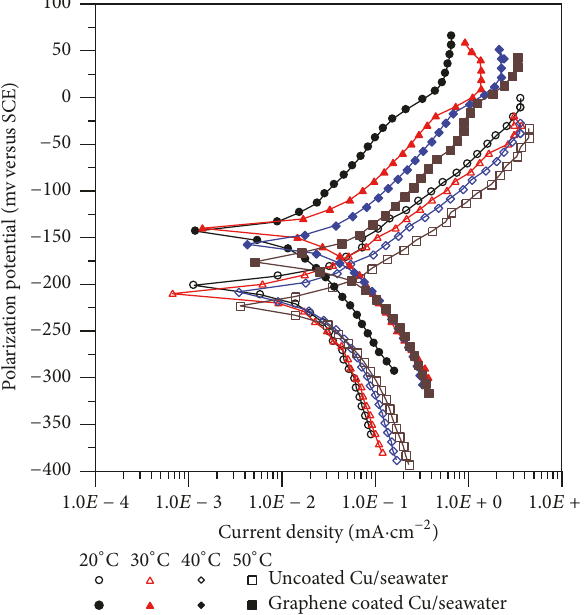
Figure 11: Tafel plots of copper specimens in seawater system without and with reduced GO coating at different temperature.